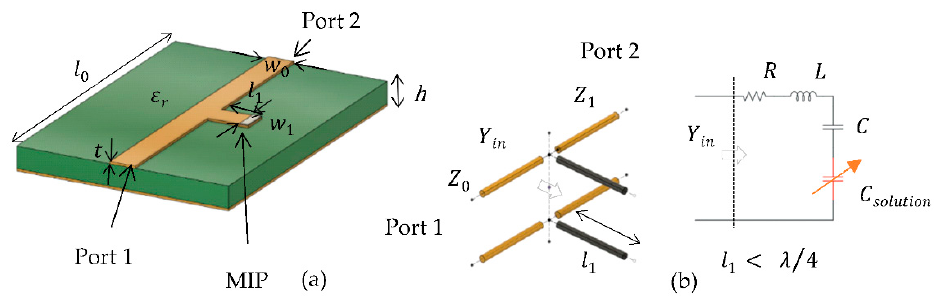
Figure 5. ( a ) Schematic illustration and ( b ) electrical equivalent model of the stub resonator with MIP.